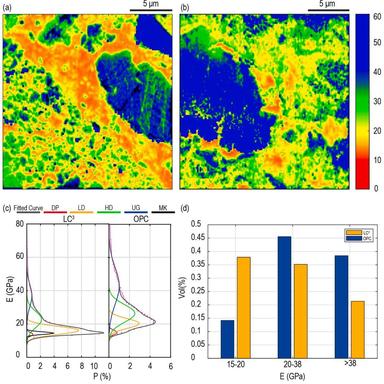
PeakForce QNM contour maps of Young's modulus (E) of (a) LC3 and (b) OPC. Statistical probability distribution of E of (c) LC3 and OPC. (d) Three characteristic E ranges of tested samples.